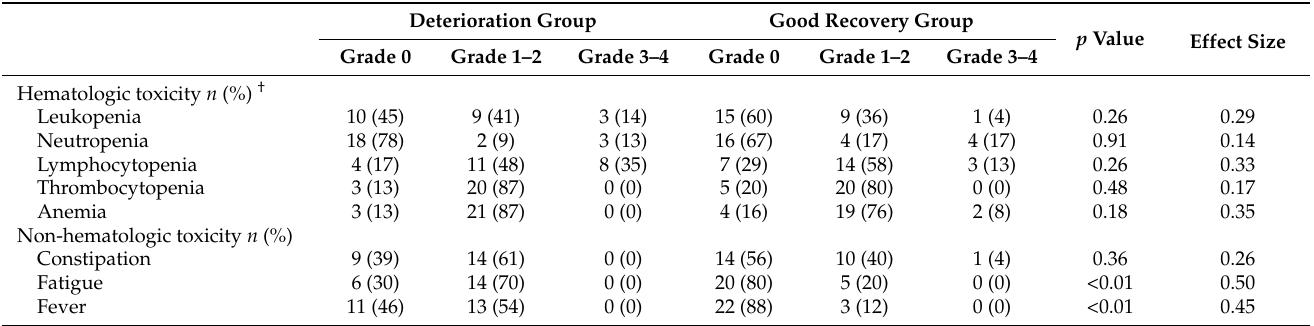
Table 4. Hematologic and non-hematologic toxicity during chemoradiotherapy in the deterioration and good recovery